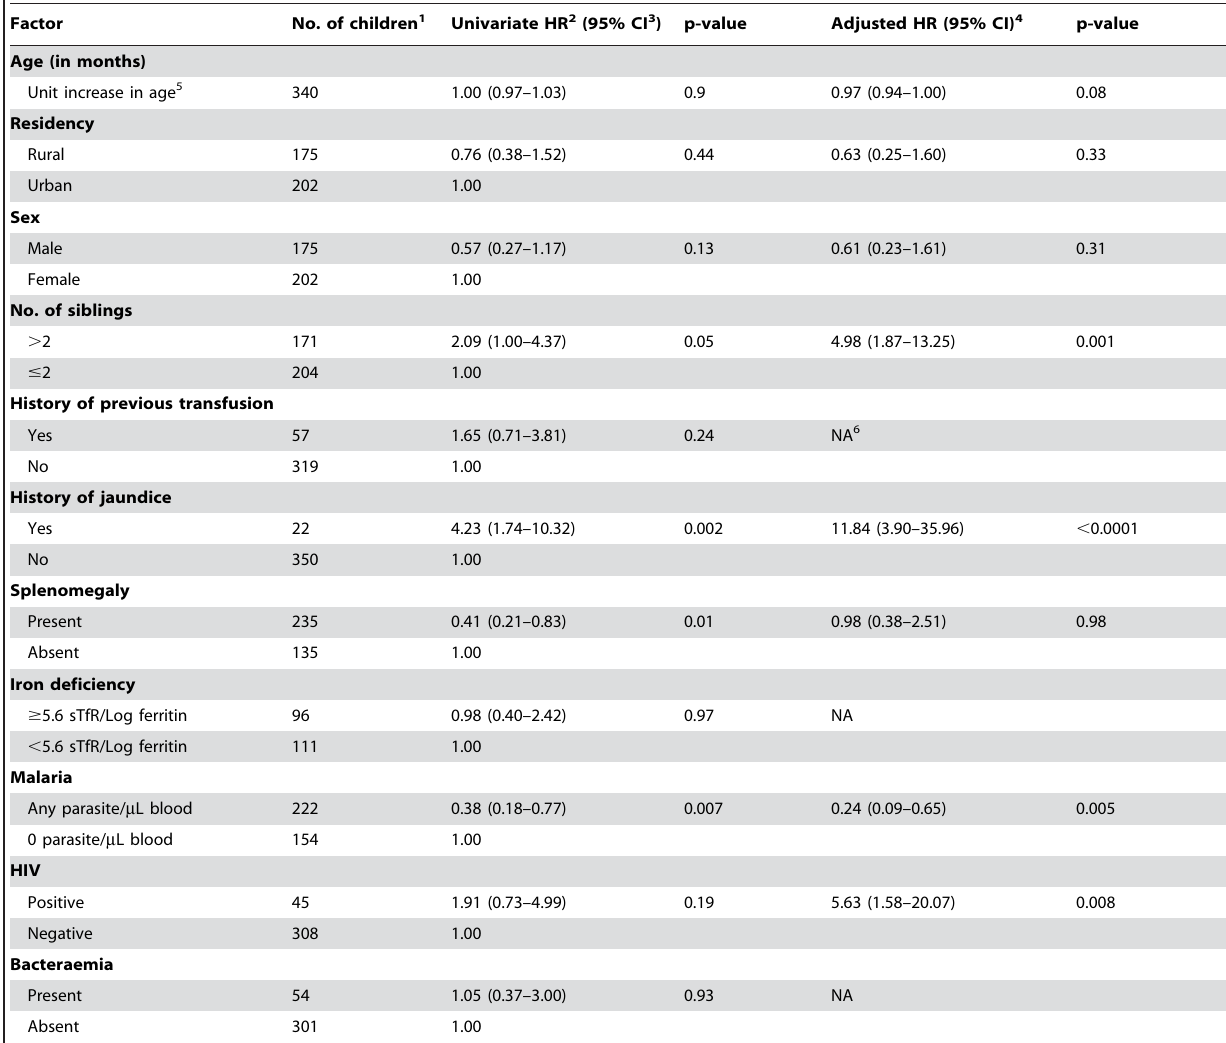
Table 5. Risk factors for recurrence of severe anaemia among